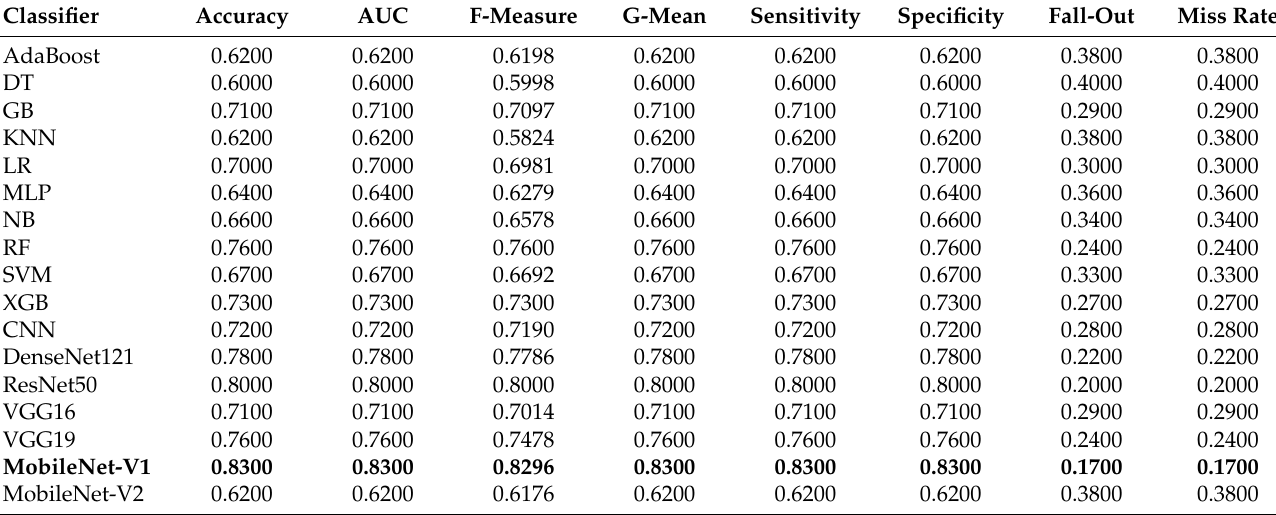
Table 1. Performance Analysis of Validation Set using Machine Learning Classifiers and Improved Pretrained